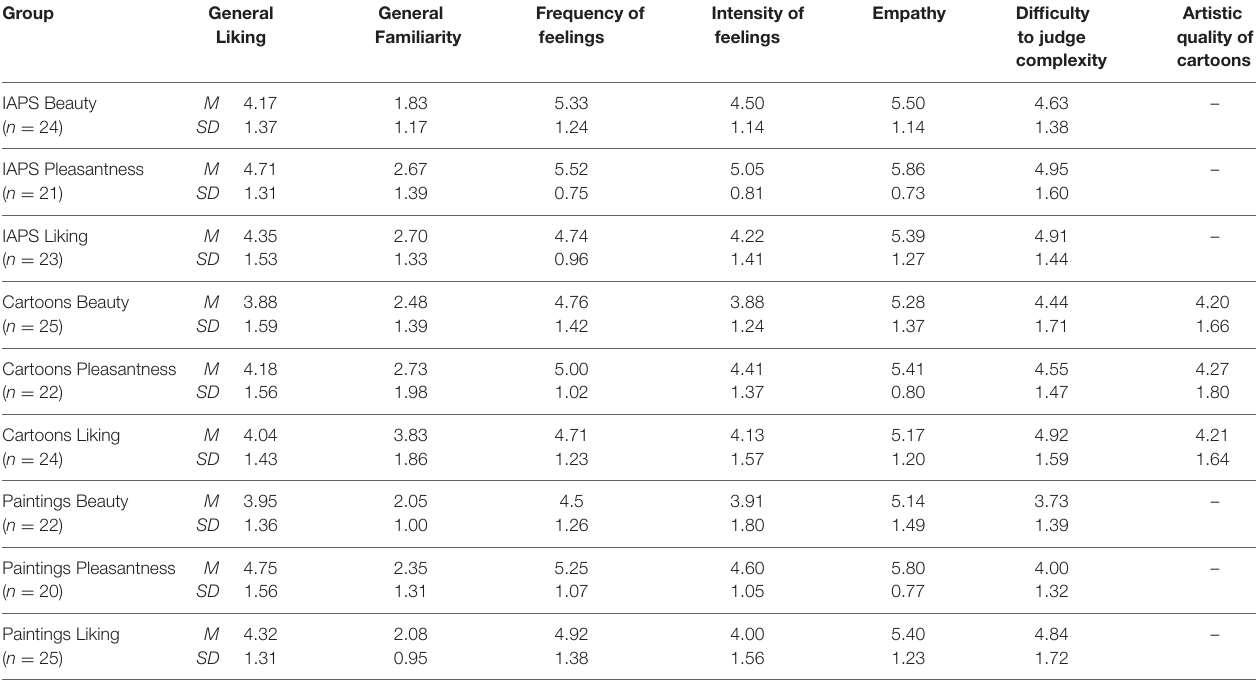
TABLE 5 | Post-experiment questionnaire. Group General